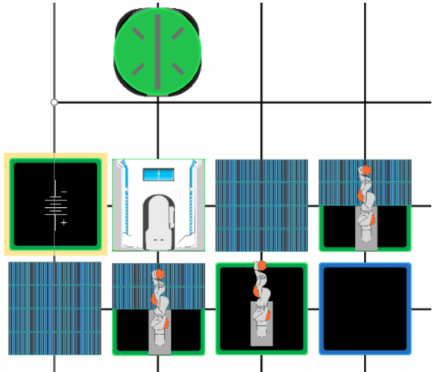
Figure 10. Power supply with modular battery platforms (yellow